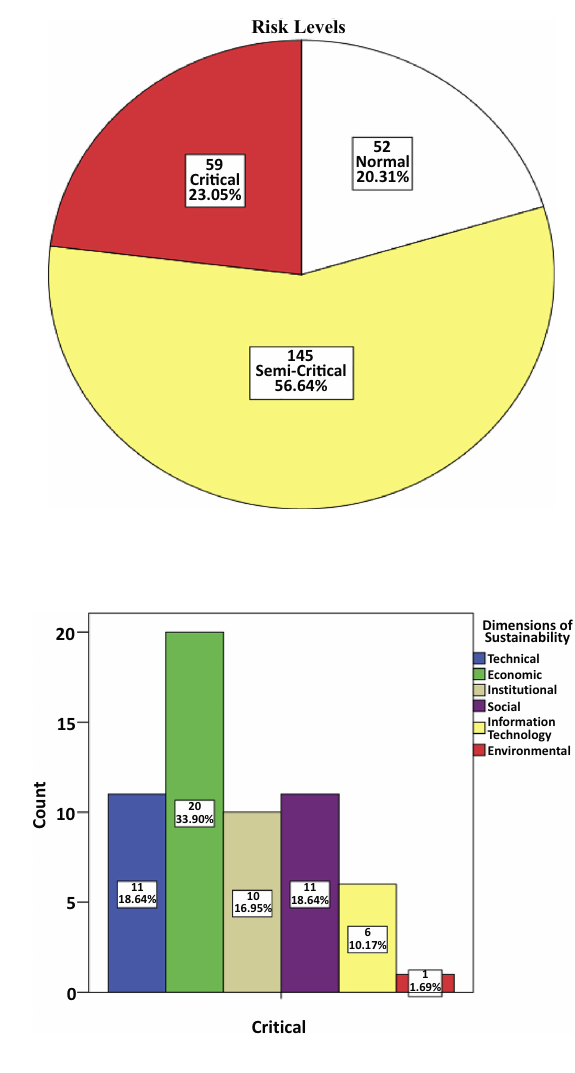
Figure 5. Dimensions of sustainability of critical supply chain